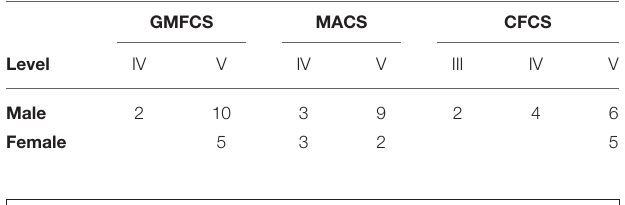
TABLE 1 | Sample distribution.